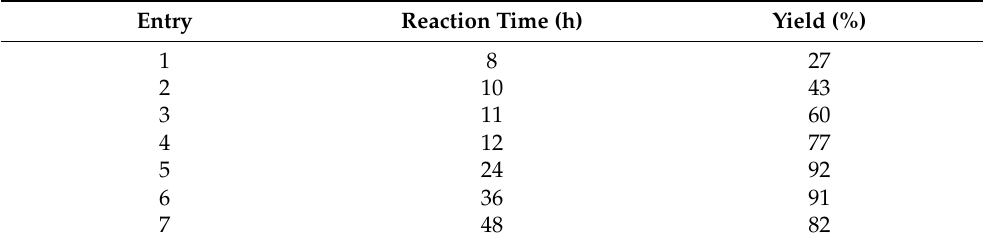
Table 2. Time course of the polymerization carried out under N 2 atmosphere in the pres- ence of CuI and Et 3 N in THF. T = 90 ◦ C; [P[5](OTf) 2 ] = [9,10-diethynylanthracene] = 0.30